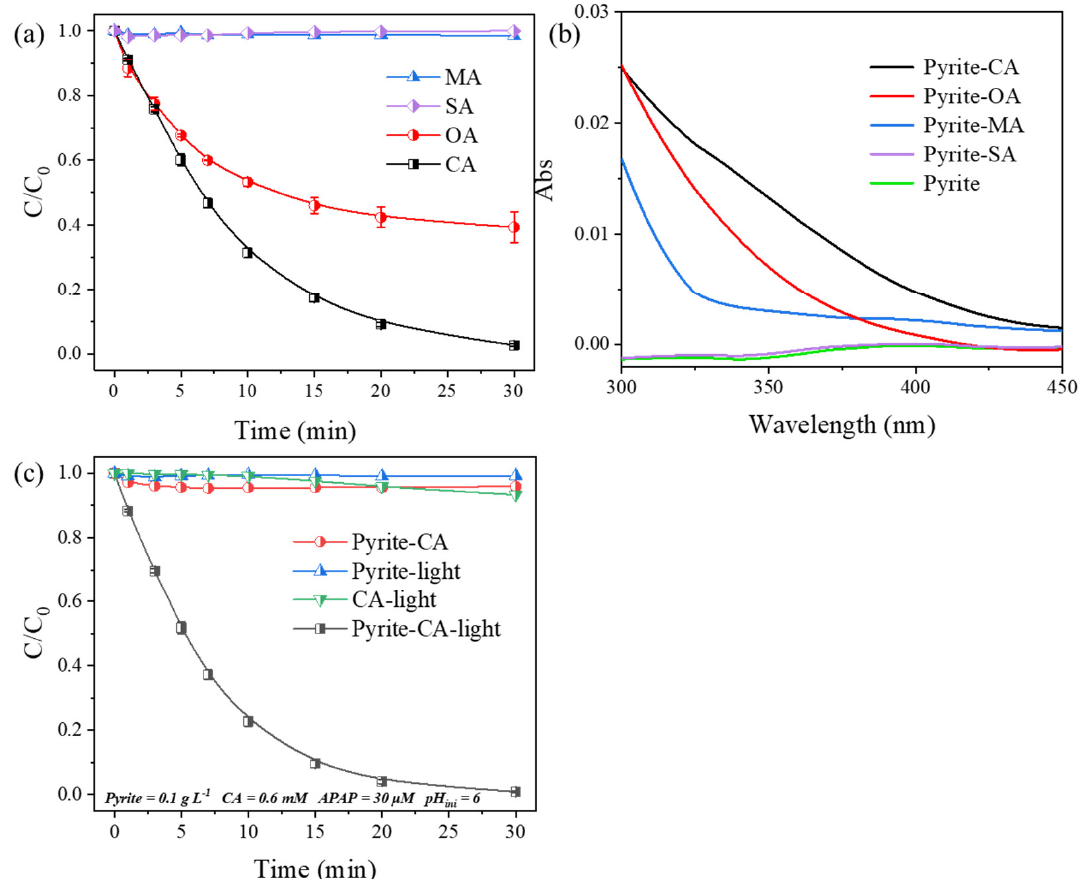
Figure 1. ( a ) Degradation of APAP in the presence of different low-molecular-weight carboxylic acids (maleic acid (MA), succinic acid (SA), oxalic acid (OA), and citric acid (CA)). Initial conditions: [pyrite] = 0.1 g L − 1 , [APAP] = 30 µ M, [LMWCA] = 1 mM, pH ini = 6. ( b ) UV–Vis absorption spectra of the reaction solutions in the presence of different low-molecular-weight carboxylic acids. Initial conditions: [pyrite] = 0.1 g L − 1 , [LMWCA] = 0.6 mM, pH ini = 6. ( c ) Degradation of APAP in different systems with or without CA. Initial conditions: [pyrite] = 0.1 g L − 1 , [APAP] = 30 µ M, [CA] = 0.6 mM, pH ini =